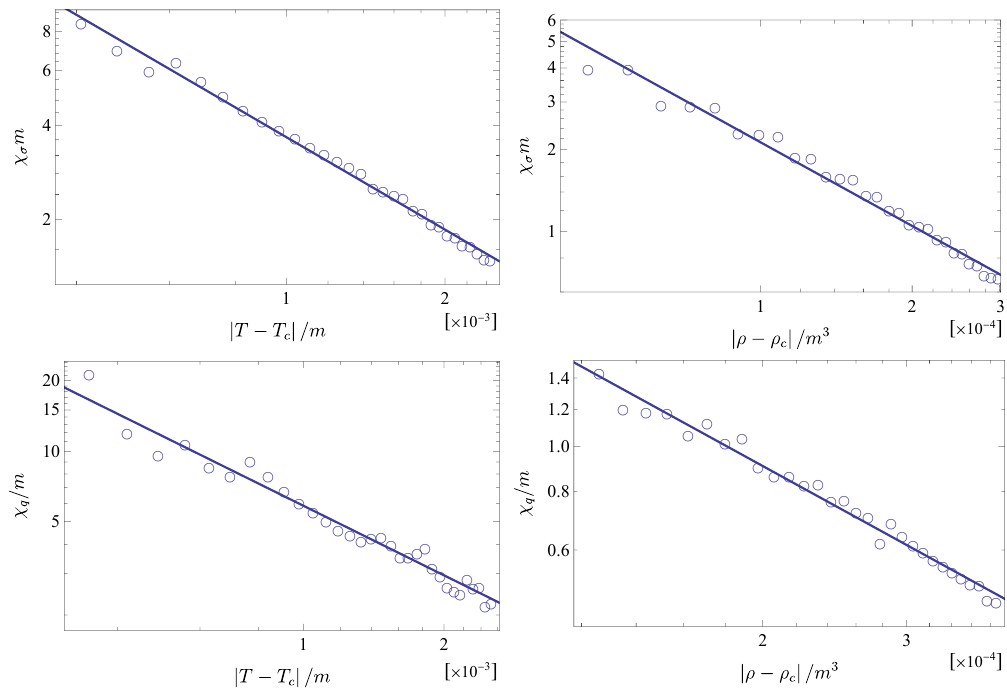
Figure 5 . The critical behaviors of the susceptibilities in the first-order phase transition region. The left (right) panels show the results with the susceptibility of the conductivity (the chiral condensate). The open circles and the solid lines denote the numerical plots and the fitting results,